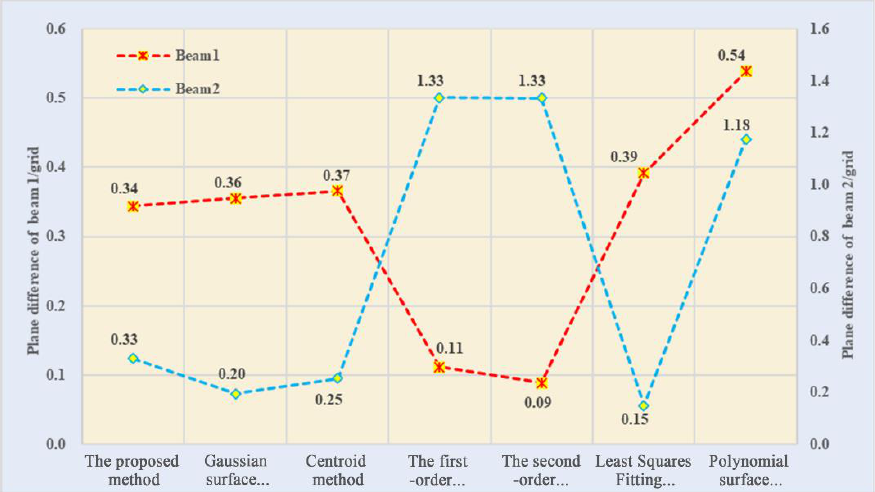
Figure 11. Plane difference between laser point calibration and centroid extraction results by seven methods.